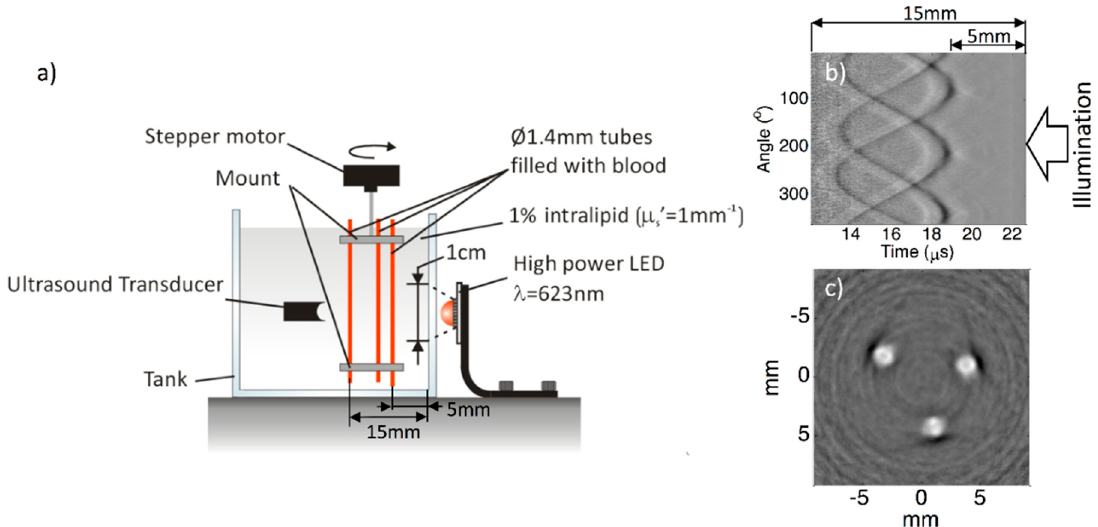
Figure 8. ( a ) Experimental setup; ( b ) RF PA signals of three 1.4 mm tubes filled with human blood immersed in water mixed with intralipid; ( c ) final reconstructed PA image. Optical output energy attained = 9 µJ. Number of frames averaged: 5000. Reproduced with permission from T. J. Allen and